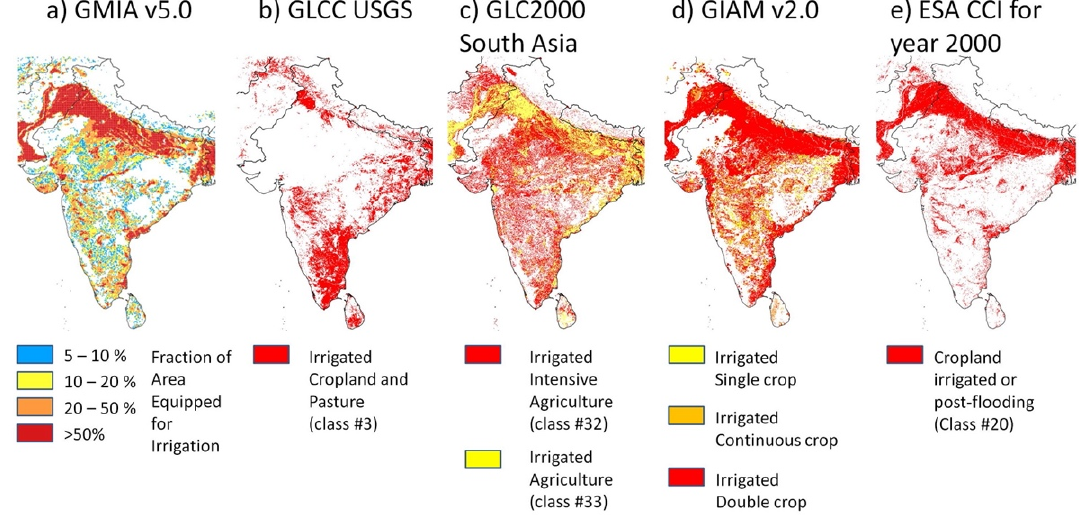
Figure 1. Mapping of irrigation in India according to ( a ) GMIA 5.0 [9], ( b ) Global Land Cover Characteristic (GLCC) USGS Land Use/Land Cover System [21], ( c ) GLC2000 for South Asia [22], ( d ) GIAM v2.0 [23], and ( e ) ESA CCI for the year 2000 [24].